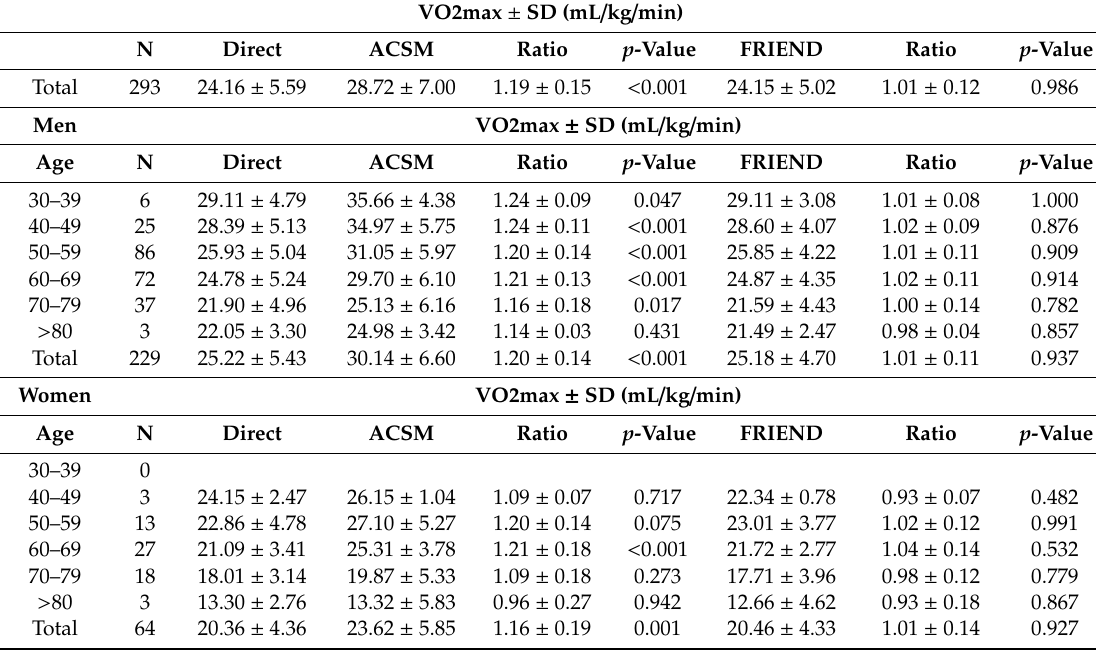
Table 3. Comparison of CRF between directly measured CRF and estimated CRF, by ACSM equation and FRIEND